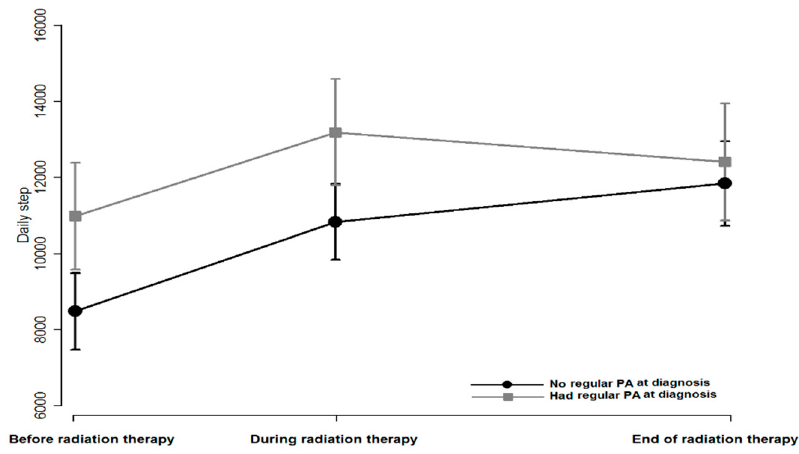
Figure 3. Average daily steps in WAT+counseling group PA, physical